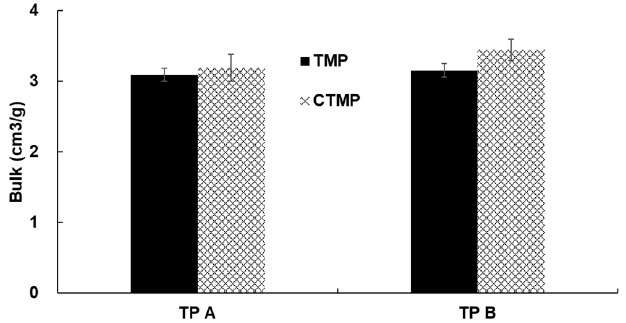
Figure 6. Change in bulk of TMP and CTMP prepared from the plates with distinctive pa tt erns.